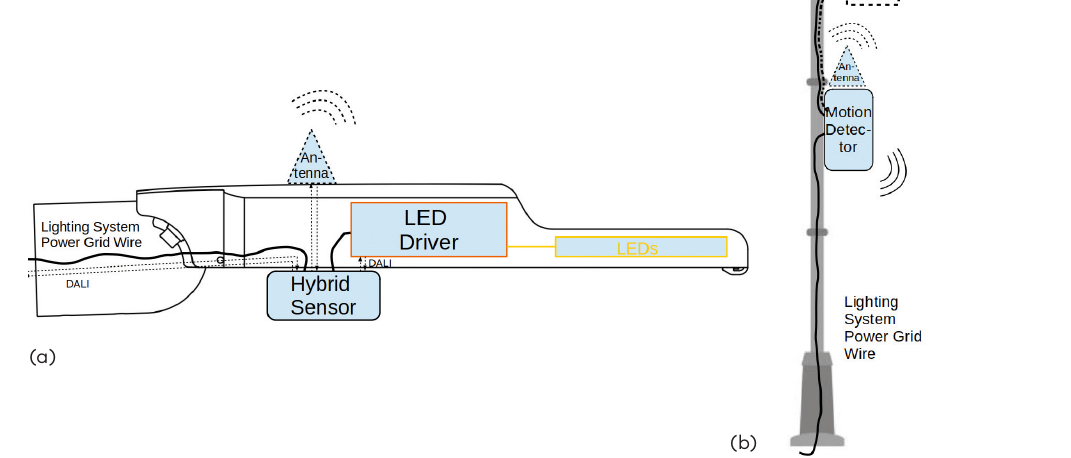
Figure 18. Two reasonable sensor installation possibilities: (a) on a